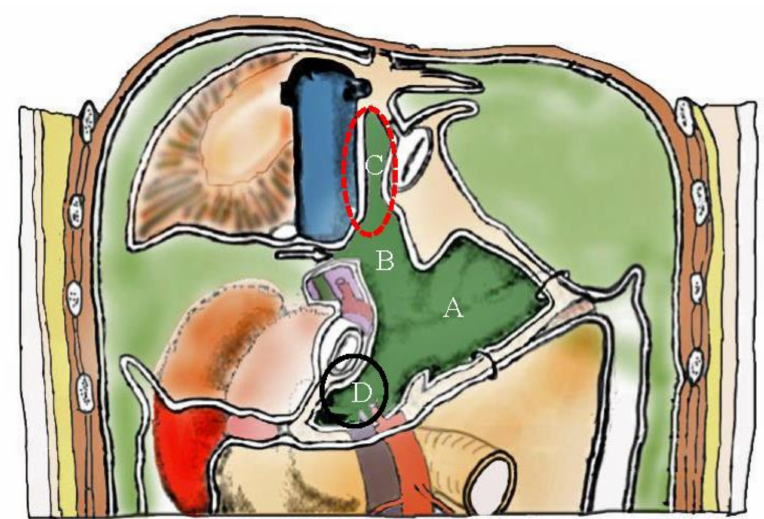
Figure 26. The omental bursa surrounded by the anterior leaf of the transverse mesocolon, pancreas capsule, posterior wall of the stomach, inferior vena cava, and the right crural muscle of diaphragm. Omental bursa opens into the peritoneal cavity through the foramen of Winslow, and consists of the greater omental sac ( A ), lesser omental sac ( B ), superior recess ( C ), and anterior vestibule ( D ). Around the duodenojejunal junction, there are two pockets, i.e., the superior